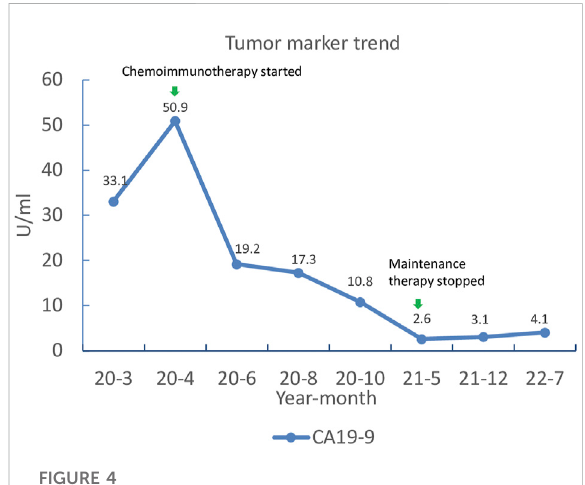
FIGURE 4 The response of tumor marker to